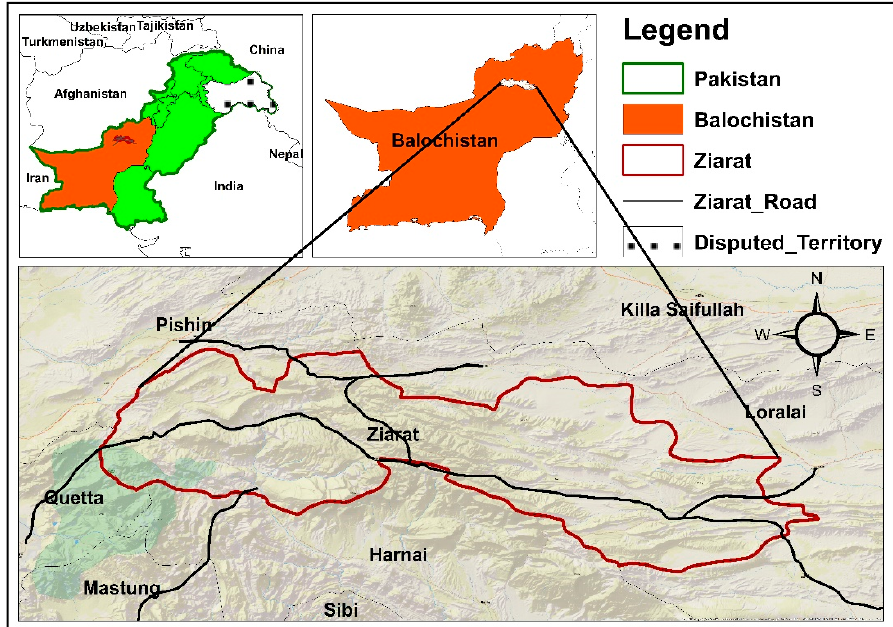
Figure 1. Study area showing district Ziarat Balochistan.